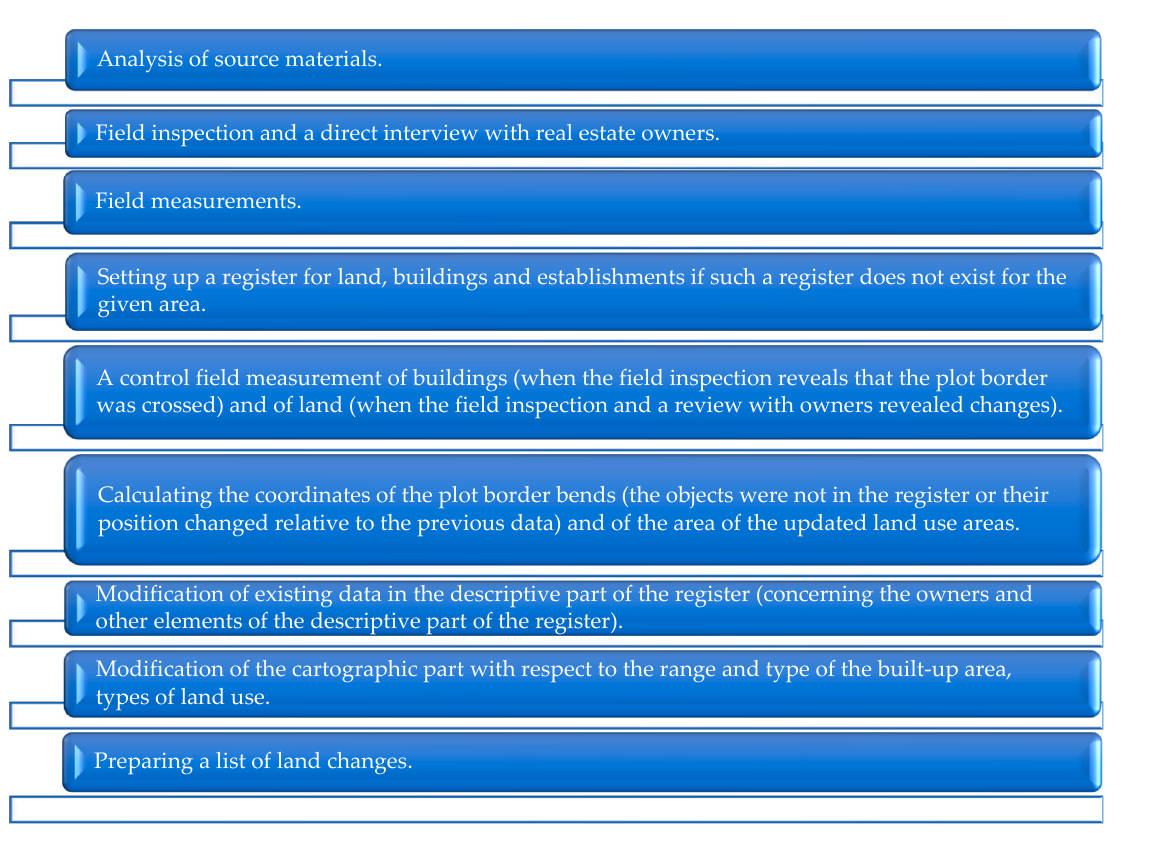
Figure 2. The detailed scope of technical measures which should be implemented during the cadastral data modernisation process. Source: own study.